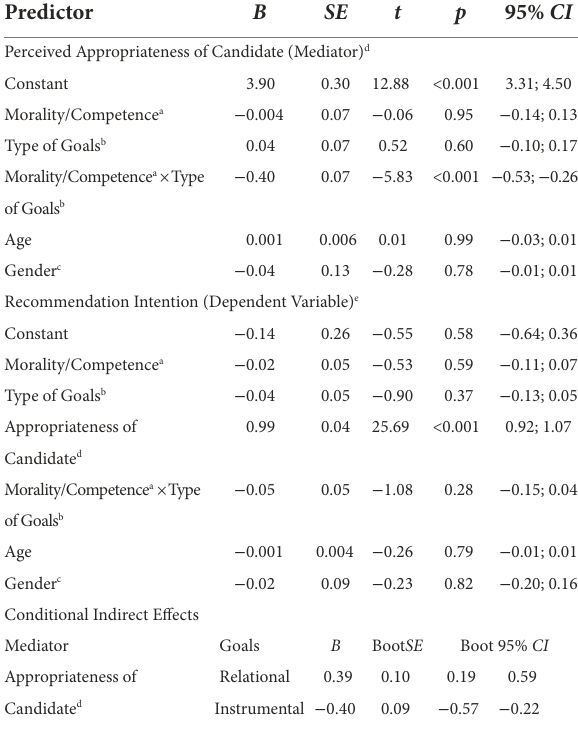
TABLE 3 Regression analyses results on perceived appropriateness of a candidate and recommendation for recruitment (Study 2).